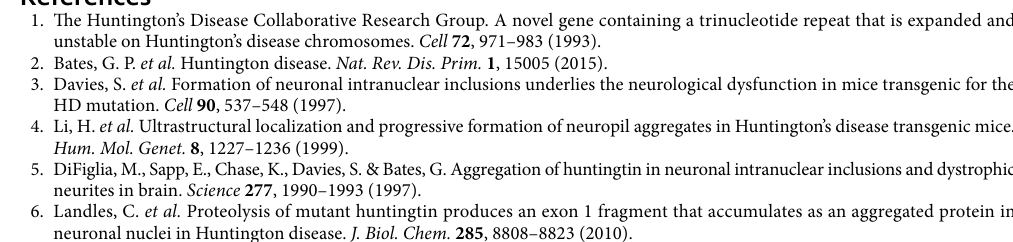
Supplementary Table S2 online. Information pertaining to probe regions and accession numbers for the Quan- tiGene multiplex assays used in this study can be found in Supplementary Tables S4 and S5 online. The median fluorescent intensity (MFI) was read in a Magpix (Luminex) using the xPonent software. Statistical analysis. Data were screened for outliers using the ROUT test (GraphPad Prism v7) and